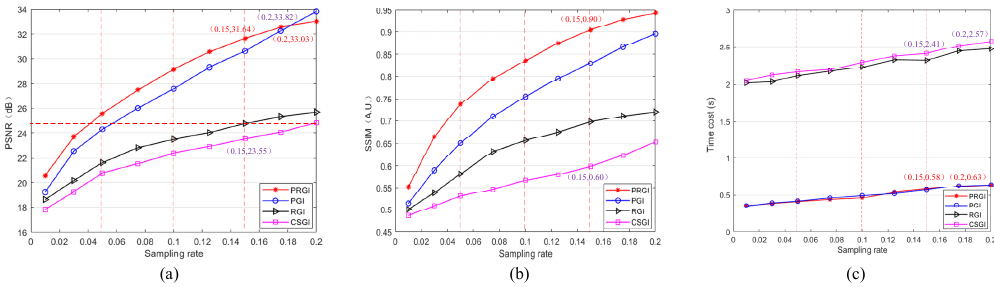
Figure 4. Quantitative analysis results of ‘CSGI’, ‘PGI’, ‘RGI’ and ‘PRGI’ under different sampling rates. ( a ) PSNR; ( b ) SSIM; ( c ) Time cost.